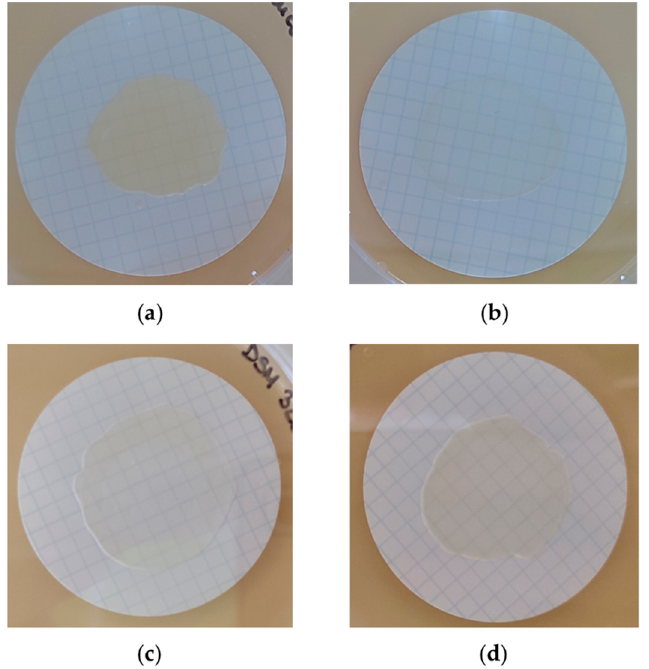
Figure 1. Biofilm formation on ø 47 mm membranes placed on BHI agar plates with 1% glucose: ( a ) S. aureus OBV 17/166; ( b ) S. aureus ATCC 25923; ( c ) S. epidermidis DSM 3269; ( d ) S. lugdunensis OBV 20/143.